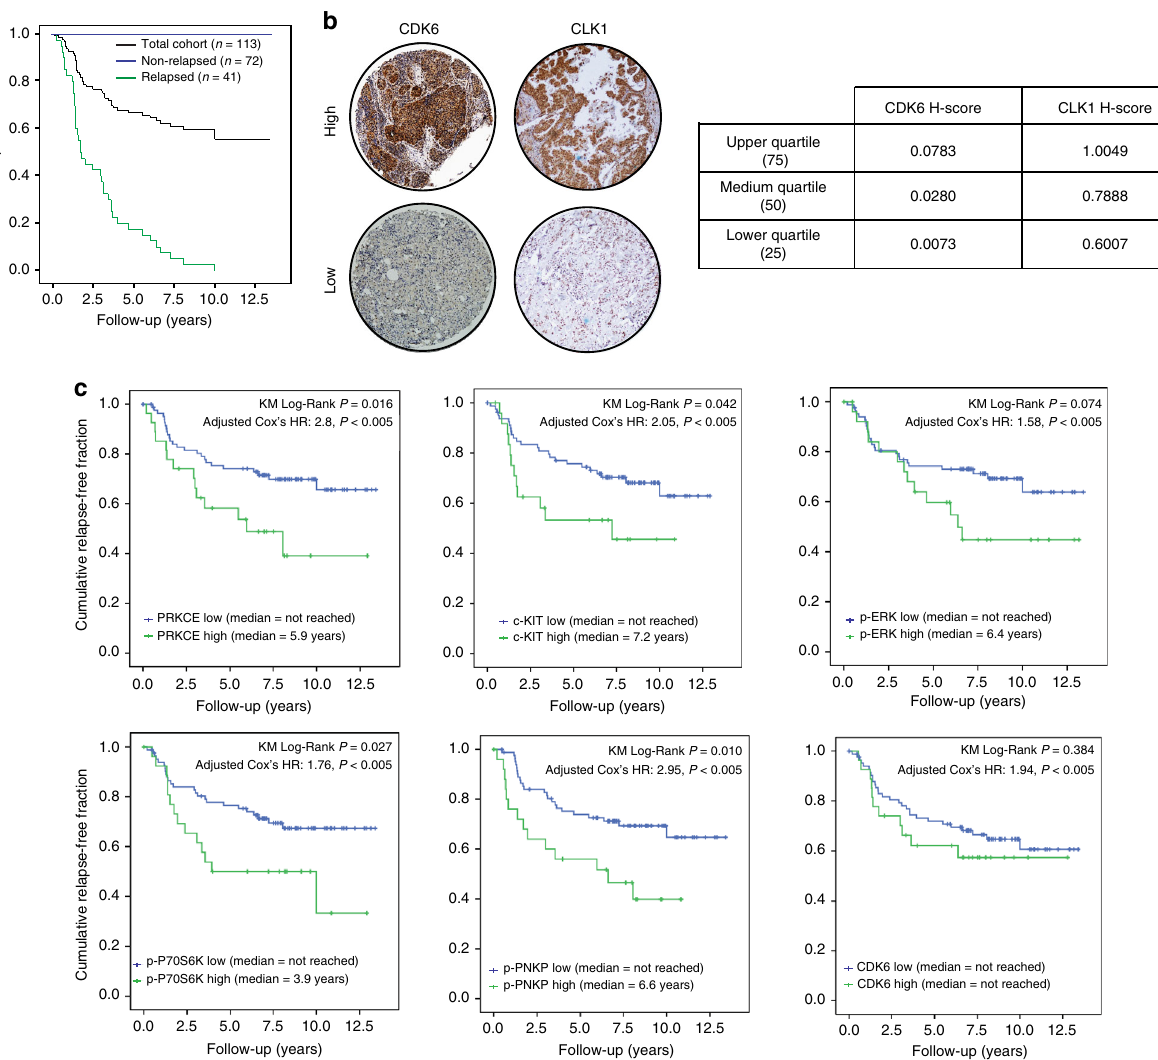
Fig. 3 Independent validation. a Kaplan – Meier survival curve of the 113 patients comprising the fi rst independent validation set — Val-1 (black chart); 72 of these patients did not relapse during 12.5 + years of observation (blue chart), whereas 41 patients did relapse (green chart). b Immunohistochemically stained examples of CDK6 and CLK1 from patients with H-scores in the upper (high) or lower (low) quartiles. c Kaplan – Meier curves according to the status (H-scores in the upper quartiles [green charts] or lower quartiles [blue charts]) of PRKCE, c-Kit, pERK (Thr 202 /Tyr 204 ), pP70S6K (Thr 389 ), pPNKP (Ser 114 /Thr 118 ), and CDK6. The upper p -values shown in each chart were derived from the log-rank test comparing median overall relapse-free survival times (KM Log-Rank p value) between patients in the upper quartiles versus the lower quartiles. The hazard ratios depicted below correspond to those for relapses attributed to each kinase in a Cox model adjusted by T, N, G, and age, and are all statistically signi fi cant (Cox P <